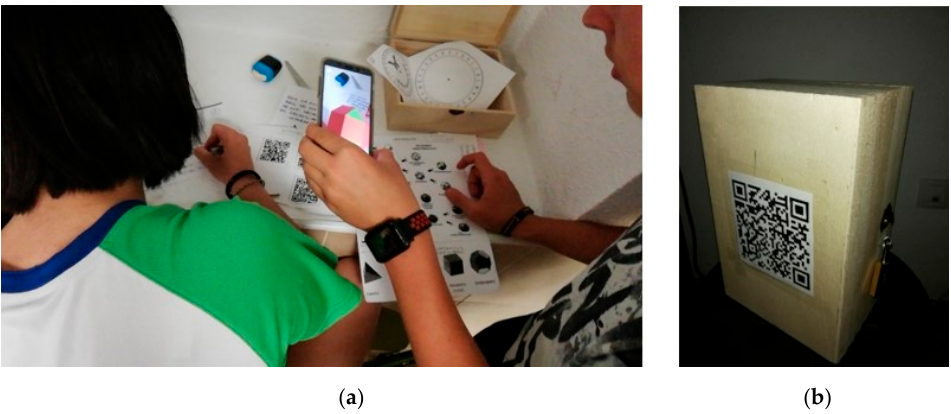
Figure 14. ( a ) students solving challenges in Breakout EDU; ( b ) clue with dual solid with invisible ink.